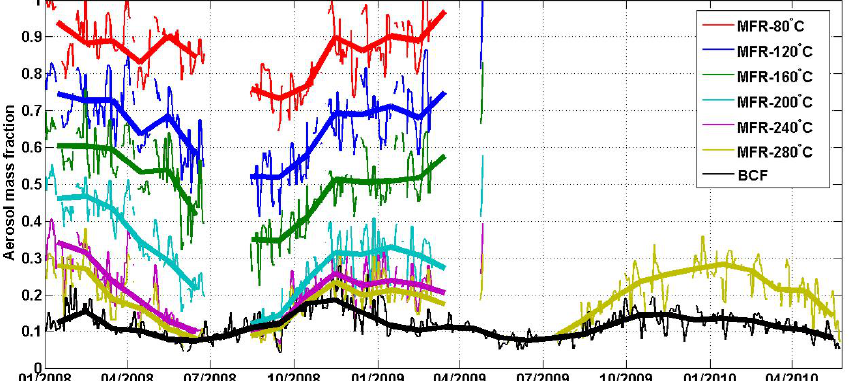
Fig. 5. Aerosol mass fraction remaining (MFR) after heating to six temperatures from 80 ◦ C to 280 ◦ C is presented (colored lines). The black line describes the maximum mass fraction of BC (BCF) in aerosol particles. Thicker lines show the monthly pattern of the parameters presented.